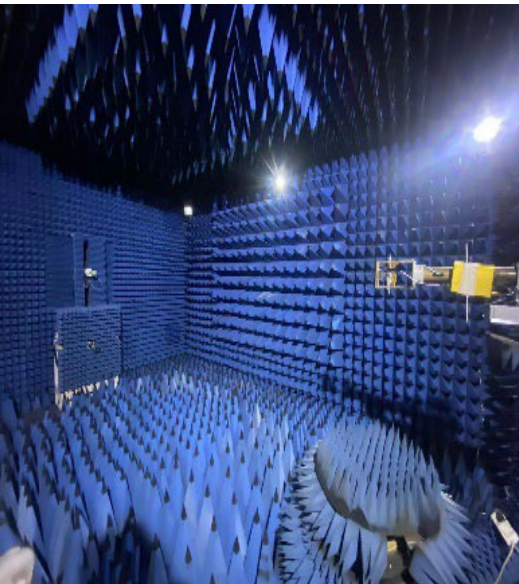
Figure 7. Ka array antenna pattern test.